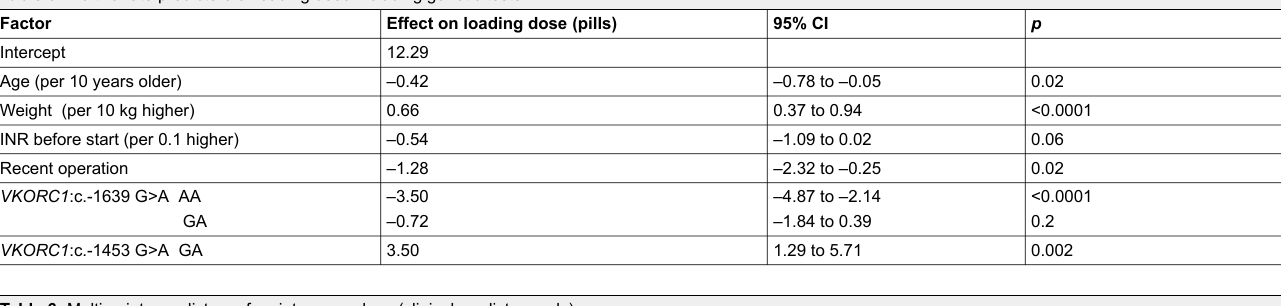
Table 6: Multivariate predictors of maintenance dose (clinical predictors only). Factor